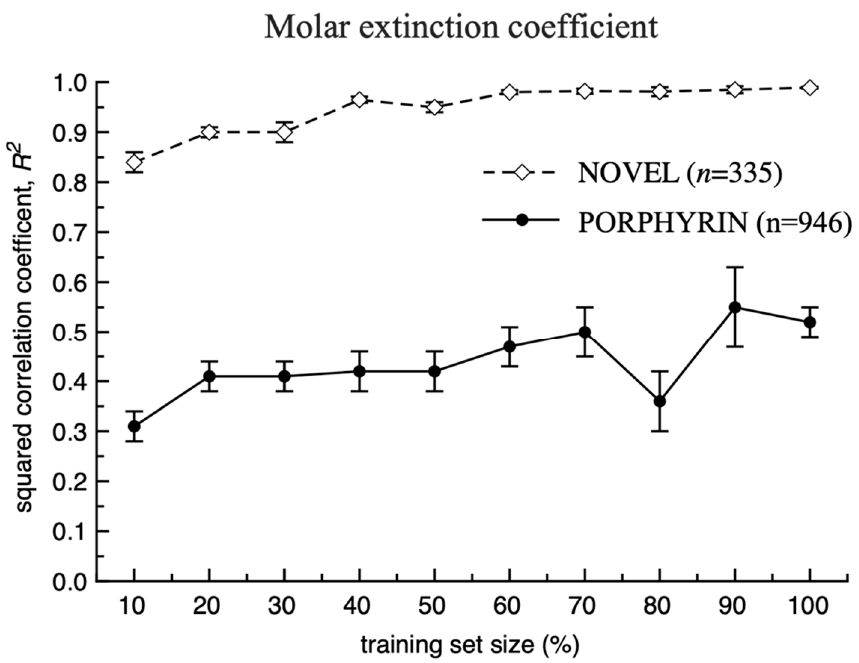
Figure 7. Statistical coefficients calculated for the prediction of the test set compounds that were not part of the respective training sets for modelling of the molar extinction coefficient (see also Supplementary Data, Tables S5 and S6). 5CV values were reported for 100% training set size.